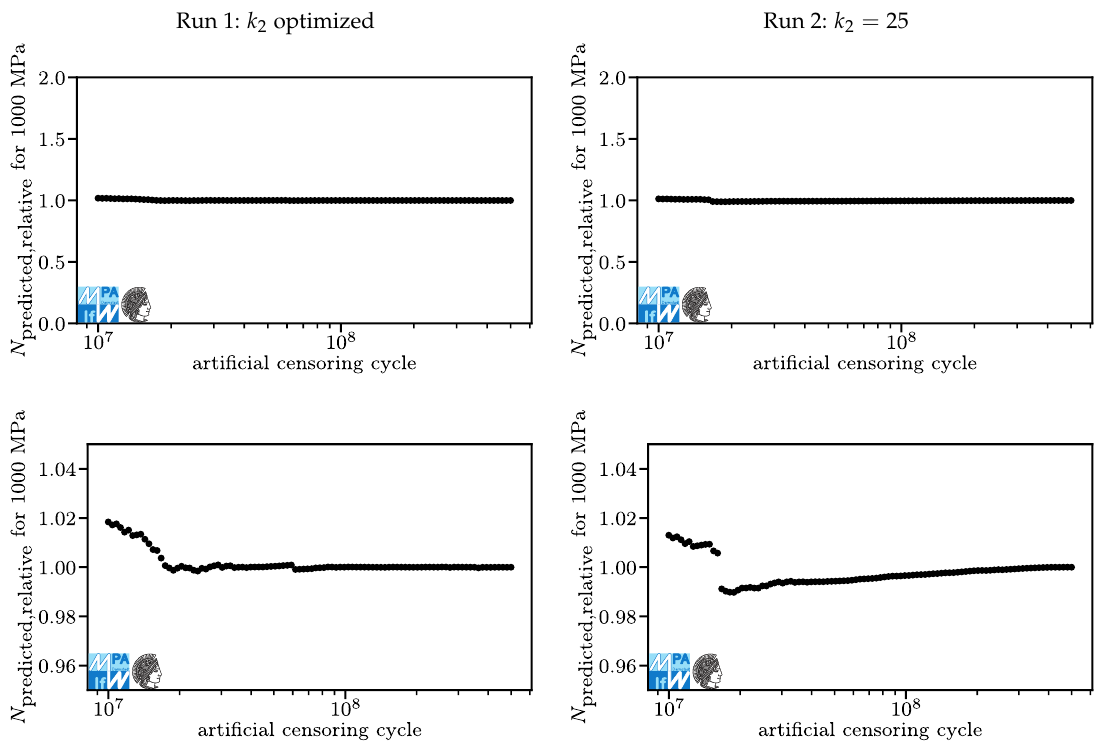
Figure 9. Lifetime predictions for Run 1 ( left ) and Run 2 ( right ), overview and detail for stroke stresses of 1000